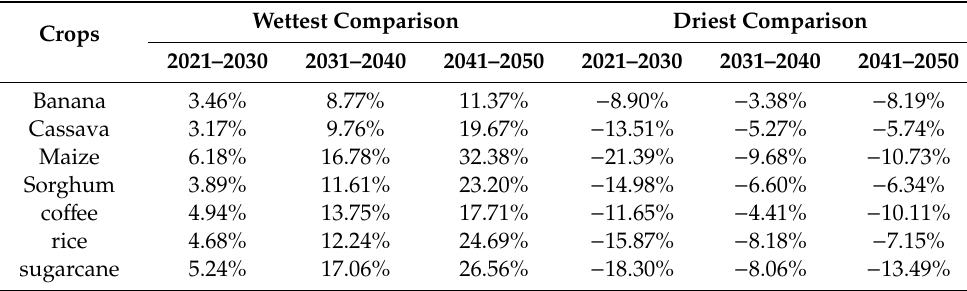
Table 2. Di ff erence in crop production between the reference and selected climate futures. Wettest Comparison Driest Crops